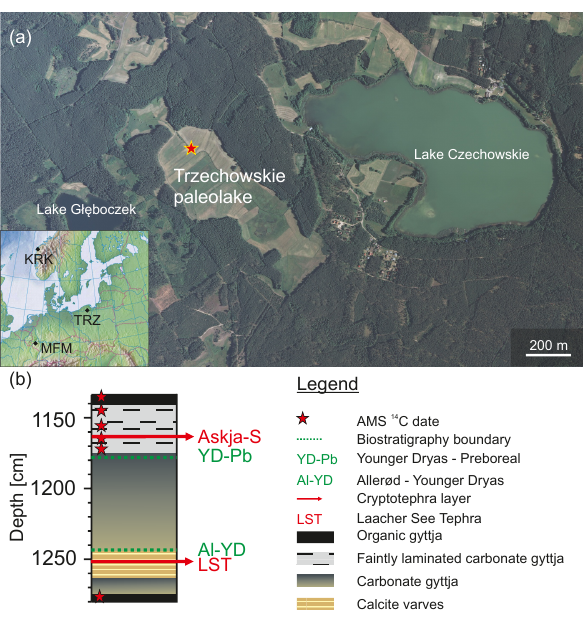
Figure 1. (a) Coring position (reddish yellow asterisk) at Trze- chowskie paleolake (TRZ). (b) Schematic overview of sampled core section with anchor points used for the age model. LST: Laacher See Tephra. MFM: Meerfelder Maar. KRK: Lake